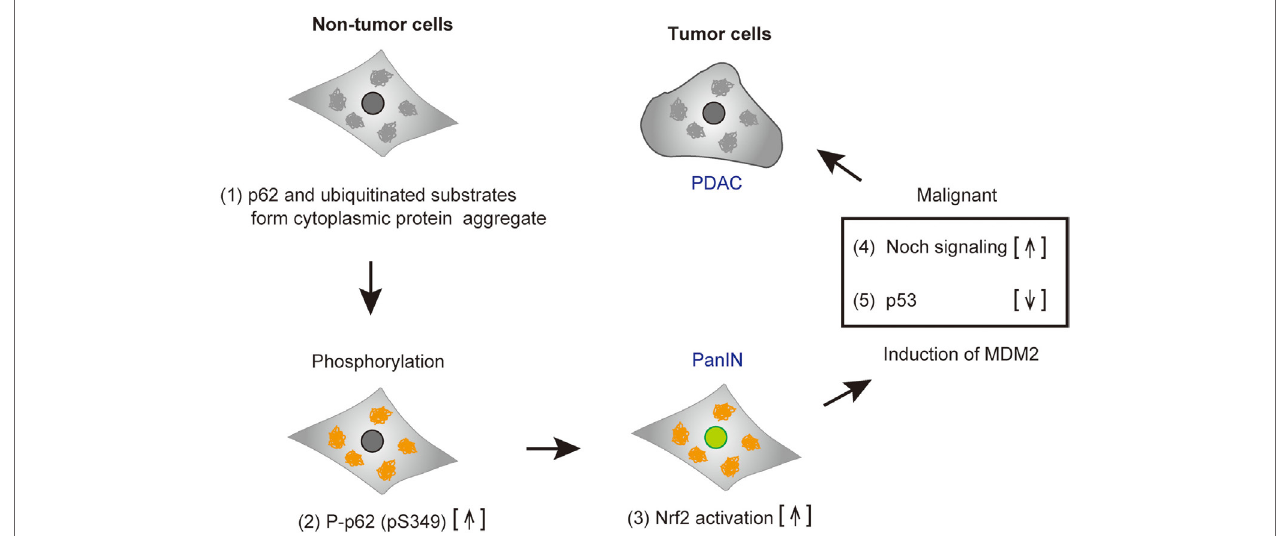
FigURe 5 | Tumorigenesis of cancer cells harboring phospho-p62. Accumulated p62 and ubiquitinated substrates form cytoplasmic protein aggregates in pre-malignant tumor cells (1). p62 is phosphorylated (2), and subsequently nuclear factor erythroid 2-related factor 2 (Nrf2) is activated (3). Mouse double minute 2 homolog (MDM2) induced by Nrf2 results in the increase of Notch signaling (4) and the reduction of p53, followed by cell malignancy (5). Abbreviations: PanIN, premalignant pancreatic intraepithelial neoplasia; PDAC, pancreatic ductal